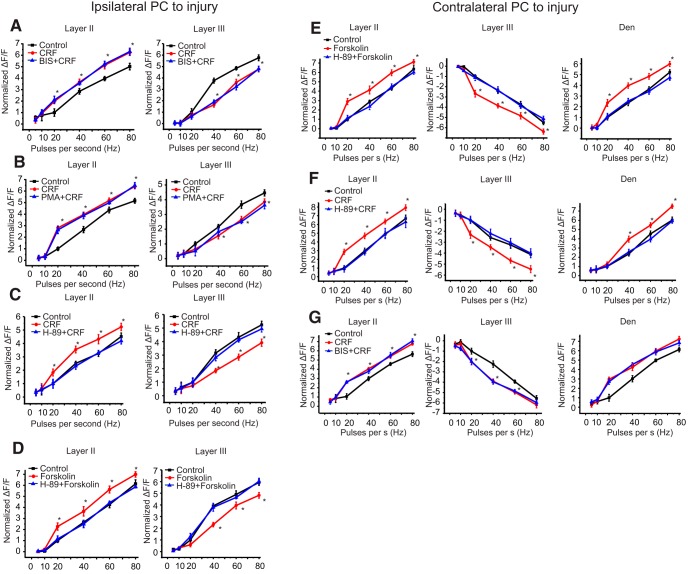
PKA and PKC antagonism in ipsilateral and contralateral PCtx in the presence of CRF. A, Quantification of the effect of BIS on CRFR1 activation in ipsilateral piriform cortical slices from brain-injured animals; *p < 0.05, n = 8 slices from eight rats/group. B, Quantification of the effect of the PKC inhibitor, PMA, on CRF-mediated activation of CRFR1 in ipsilateral piriform cortical slices from brain-injured animals; *p < 0.05, n = 9 slices from eight rats/group. C, Quantification of the effect of the PKA antagonist H89 on CRF-mediated activation of CRFR1 in ipsilateral piriform cortical slices from brain-injured animals; *p < 0.05, n = 9 slices from seven rats/group. D, Quantification of the effect of forskolin, an adenylate cyclase activator with or without subsequent administration of H89 on ipsilateral piriform cortical slices from brain-injured animals; *p < 0.05, n = 8 slices from six rats/group. E, Quantification of the effect of forskolin (an adenylyl cyclase activator) with or without subsequent administration of H89, on CRFR1 activation in contralateral piriform cortical slices from brain-injured animals; *p < 0.05, n = 7 slices from six rats/group. F, Quantification of the effect of the PKA inhibitor H89 on CRF-mediated activation of CRFR1 in contralateral piriform cortical slices from brain-injured animals; *p < 0.05, n = 6 slices from six rats/group. G, Quantification of the effect of the PKC antagonist BIS on CRF-mediated activation of CRFR1 in contralateral piriform cortical slices from brain-injured animals; *p < 0.05, n = 6 slices from six rats/group.